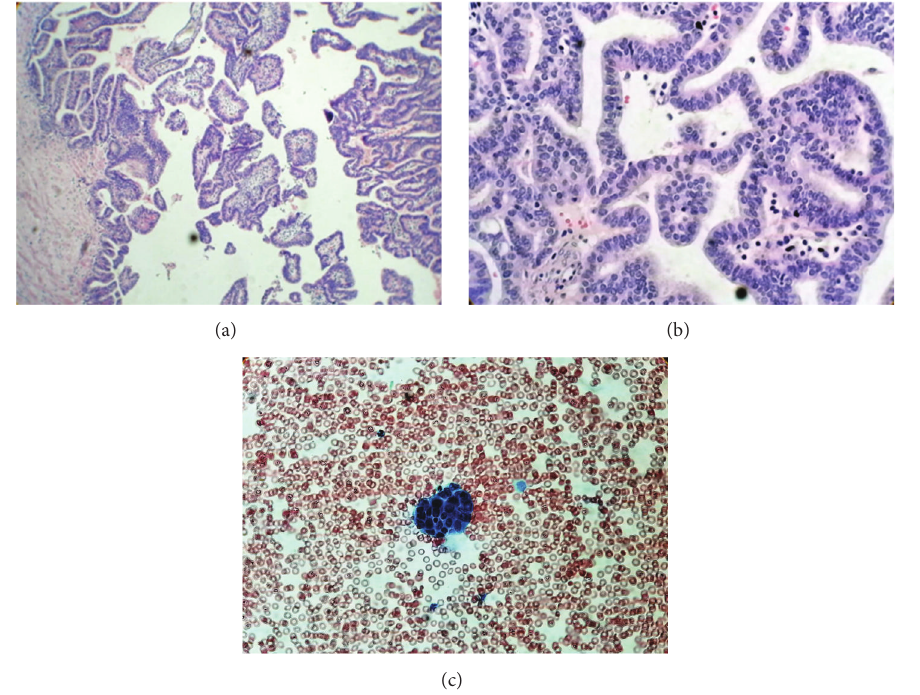
Figure 4: H&E stain, microscopic image. (a) 10x magnification. Architecture of paraovarian endometrioid borderline cystic tumor with villoglandular pattern. (b) 40x magnification. (c) 40x peritoneal wash. Pleomorphic, well-differentiated endometrioid groups of tumor cells, found in a peritoneal